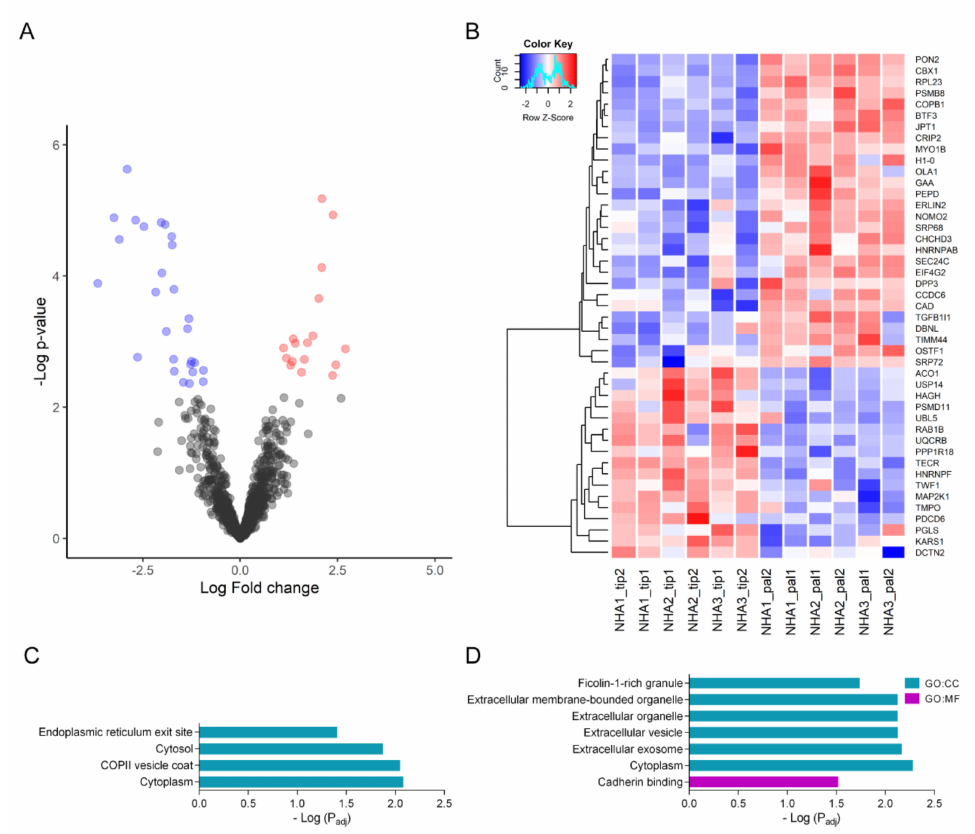
Figure 4. Differential expression of tip vs. pal. ( A ) Volcano plot showing differentially expressed proteins with adjusted p -value < 0.01 and |Fold change| ≥ 1.5. ( B ) Heatmap of proteins differentially expressed proteins in tip vs. pal. Color scale: variation of normalized protein abundance (Z-Score). ( C ) Enrichment analysis of up-regulated proteins in tip vs. pal ( p < 0.05). ( D ) Enrichment analysis of down-regulated proteins in tip vs. pal ( p < 0.05). GO:CC: Gene Ontology cellular component; GO:MF: Gene Ontology molecular